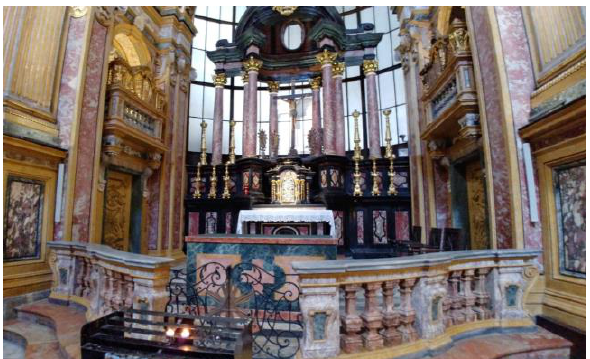
Figure 2. The two symmetrical doors on the side of the altar.